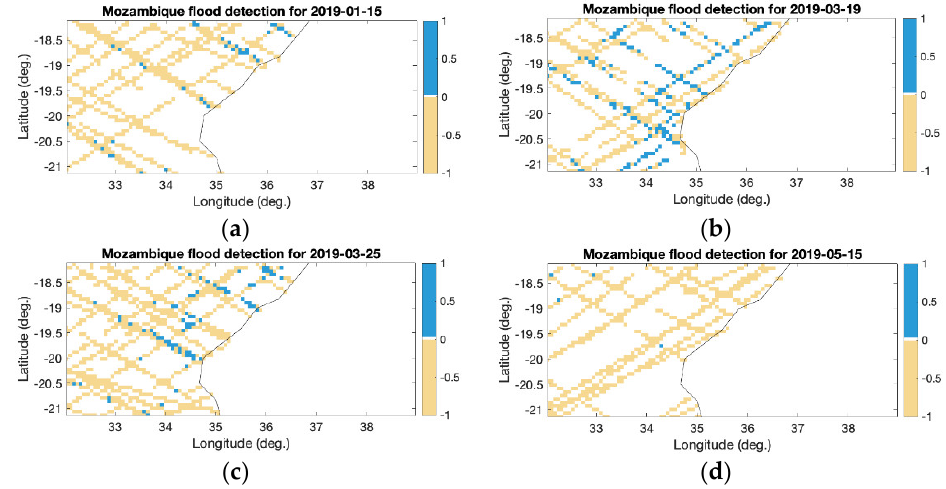
15 January 2019, 19 March 2019, 25 March 2019 and 15 May 2019, using SNR and TES information respectively.